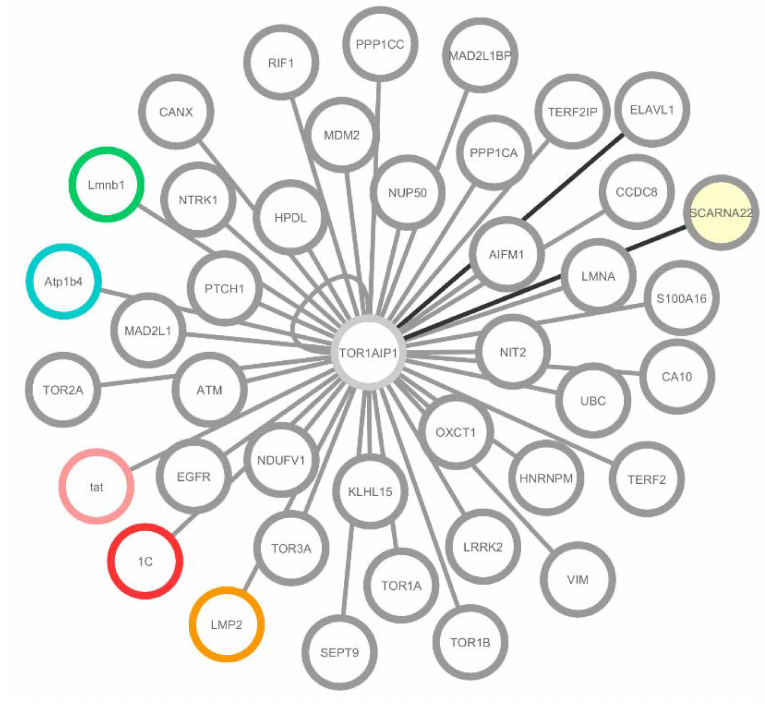
Figure 2. LAP1 interactome built using Cytoscape 3.2.1 [1]. Of these interactions, 36 were verified in human ( grey ); one in mouse and rat ( blue ); one only in rat ( green ); and three between human LAP1 and viral proteins ( pink for HIV-1, red for HRSVA and orange for HHV-4). All the white nodes represent proteins, while RNA is denoted with yellow filling. Grey edges signify protein-protein interaction, while protein-RNA or RNA-RNA interactions are coloured with black edges. LAP1 is also able to form dimers, which is represented by a self-binding